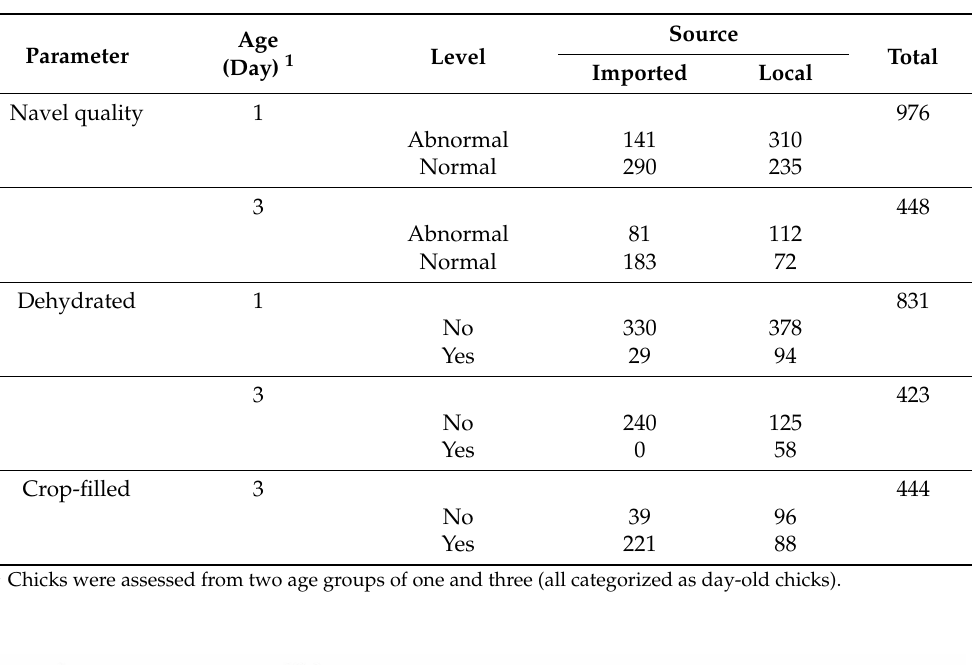
Table 1. Frequency distribution of day-old chicks (n = 1647) by the categorical quality parameters in the study.